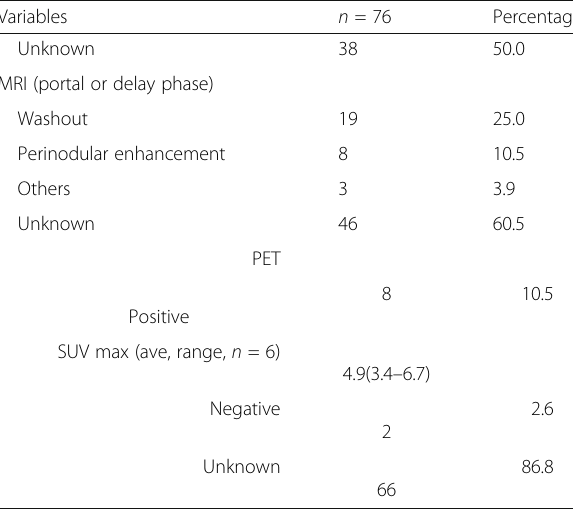
Table 1 Clinicopathological features of reactive lymphoid hyperplasia of the liver